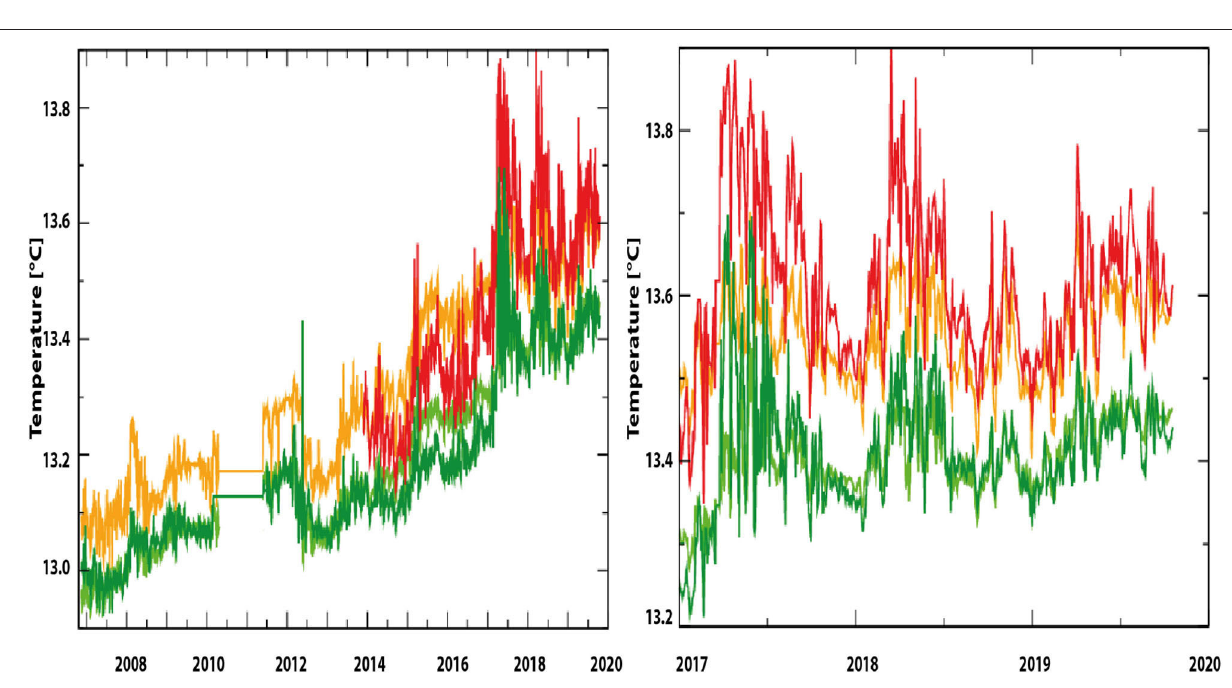
Sill depth) and the vertical turbulent diffusion. Other processes dSAP are only visible during a few months on two